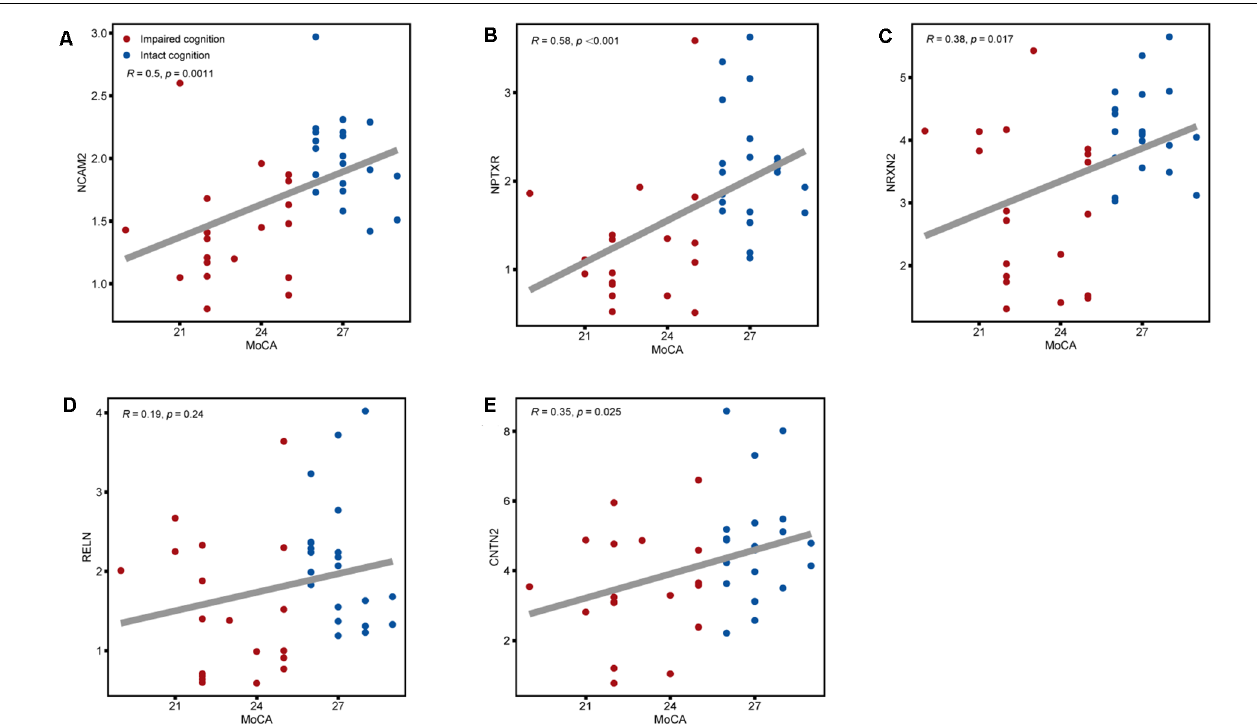
FIGURE 5 | Associations between the five CSF candidate biomarkers for impaired cognition and actual scores on the MoCA. Scatter plots of MoCA scores and CSF levels of (A) NCAM2, (B) NPTXR, (C) NRXN2, (D) RELN, and (E) CNTN2 across the impaired cognition group (red) and the control group (blue). Associations were assessed using Spearman partial correlations adjusted for cohort. To correct for multiple comparisons, p values were corrected using a false discovery rate (FDR)